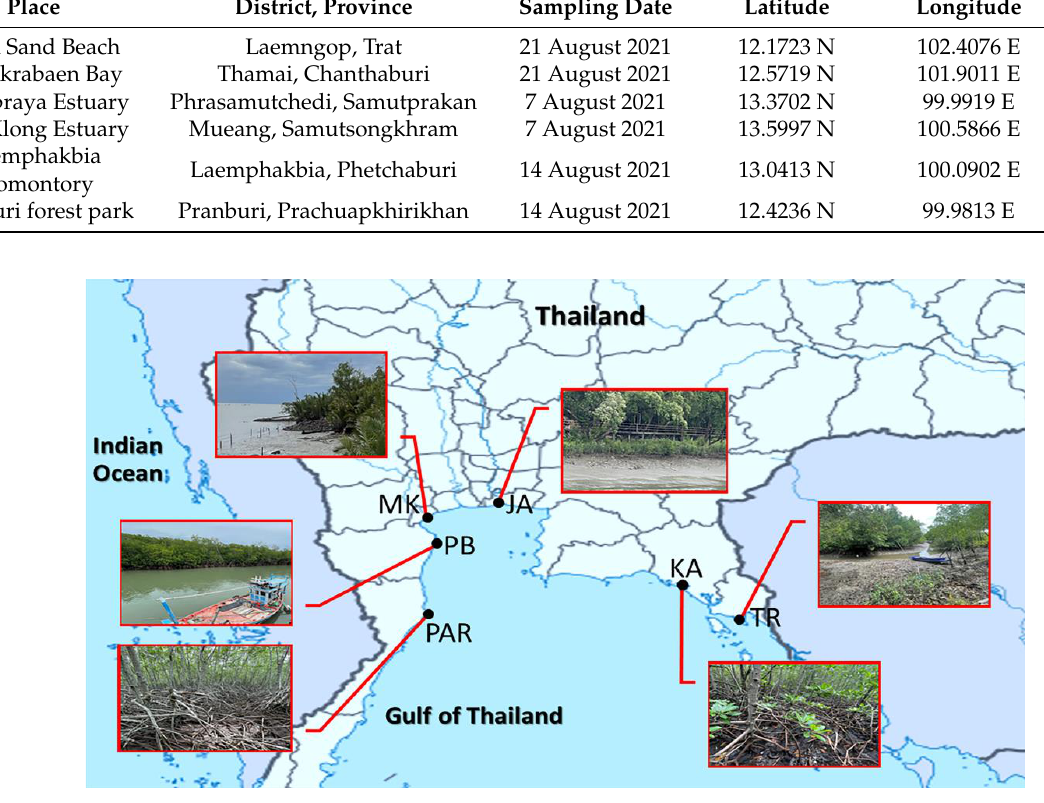
Figure 1 . Map of sampling sites along the shores of the Upper Gulf of Thailand . The site codes are in Figure 1. Map of sampling sites along the shores of the Upper Gulf of Thailand. The site codes are in accordance with those listed in Table 1 . The photographs of sampling sites were taken by the authors . accordance with those listed in Table 1. The photographs of sampling sites were taken by the Soil samples were randomly collected at a 0 to 10 cm depth and a weight of 6 kg per site according to Li et al . [ 21 ] and mixed thoroughly . The mixed soil sample was divided into two portions . For the first portion, 20 g of soil was preserved with Sample - NAP Seq stabilization solution ( Bioentist, Bangkok, Thailand ) , immediately stored in an ice box, and subjected to soil DNA extraction . For the second portion, soils were kept in sterile polyethylene bags, immediately stored in ice boxes, and subjected to soil physicochemical analyses . Once arrived at the laboratory, soil samples of both portions were immediately stored in a − 80 °C fridge . For surface water collection, surface water in a volume of 1 L per site was collected, immediately stored in ice boxes, and used for the determination of physicochemical parameters . All sampling sites were public areas thus no specific author- ization was required for sample collection . 2 . 2 . Determination of Soil and Water Physicochemical Parameters For soil physicochemical analyses, 2 kg of soil from each sampling site were air - dried and sieved through a sterile 10 - mesh sieve with a 2 - mm aperture size . Soil EC and pH were measured as described by Jackson [ 22 ]. Soil particle size distribution was analyzed as described by Bouyoucos [ 23 ]. OM content was determined following the method of Walkley and Black [ 24 ]. Amounts of P, Fe, Ca, Cu, Mn, and Zn were determined by the Bray II method [ 25 ]. Amounts of K and Mg were analyzed by the Flame photometric method [ 22 ]. The quantity of N was analyzed as described by Li et al . [ 21 ]. For surface water parameter analyses, pH and NaCl concentration were measured by a benchtop pH meter ( Metrohm 827 pH Lab, Herisau, Switzerland ) and a refractometer ( Atago N - 1E, Tokyo, Japan ) respectively, following the standard procedures of American Public Health Association ( APHA ) [ 26 ]. One hundred milliliters of each surface water sample was fil- tered using Whatman filter paper no . 1 and then 10 mL of 3 % nitric acid ( HNO3 ) was added into the filtrate [ 27 ]. Concentrations of 13 heavy metals in surface water ( Cd, Cr, Ag, Se, Cu, Al, Ba, Hg, Mn, As, Zn, Pb, and Fe ) were determined using an inductively coupled plasma - mass spectrometry ( ICP - MS ) ( Agilent ICP - MS 7900, Santa Clara, CA, USA ) as described by Abdul et al . [ 28 ]. 2 . 3 . Soil DNA Extraction and Illumina NGS Soil DNA of three replicates per sample was extracted by a NucleoSpin soil kit ( Macherey - Nagel, Duren, Germany ) following the manufacturer ’ s instructions . Then, the